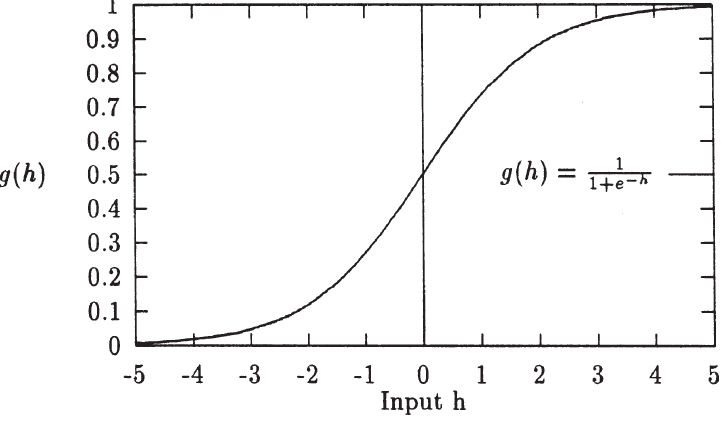
Fig. 2. A sigmoidal shaped function (one that saturates for extreme input values) is the most common nonlinear activation function used with neural